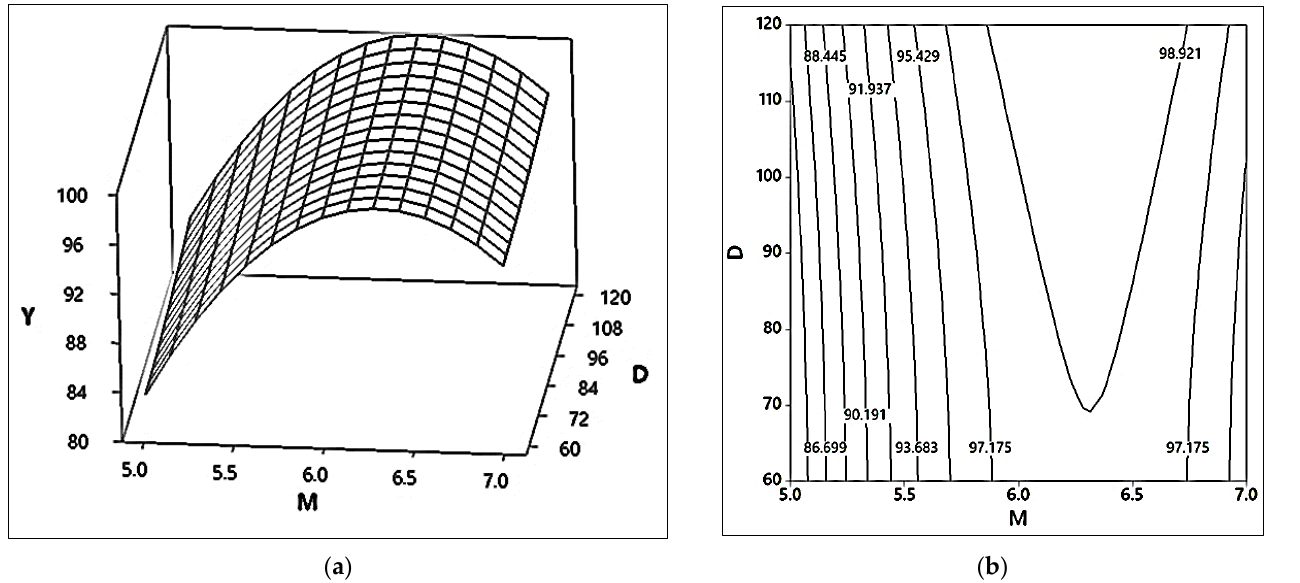
Figure 16. Interaction effect of the reaction time (D) and methanol to oil molar ratio (M) on the FAME yield (Y) of the transesterification process. ( a ) A 3D response surface plot of Y (%) vs. D (minutes) and M (M). ( b ) A 2D contour plot between D (minutes) and M (M).